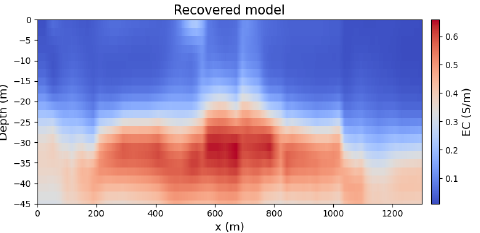
Figure 5. Recovered model from real field data from Delsman et al.